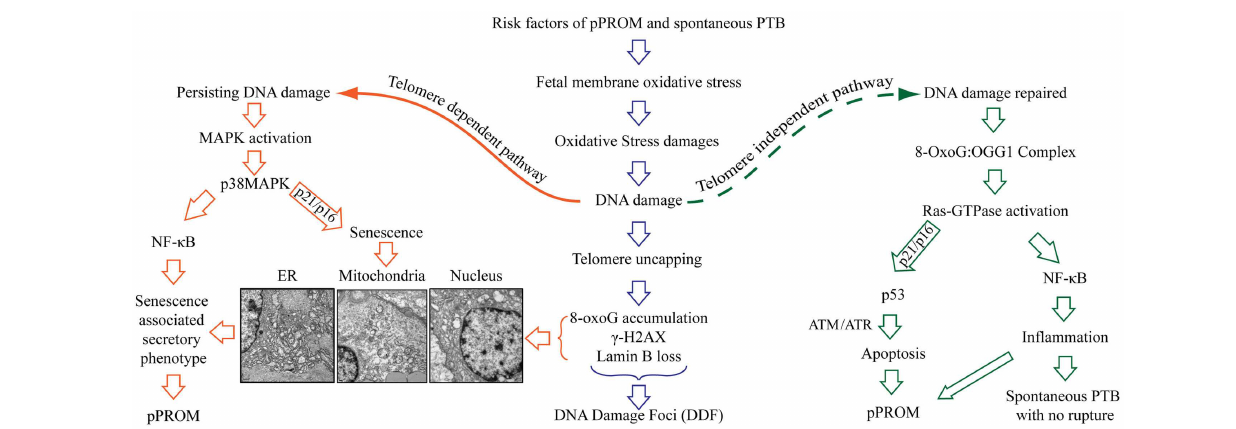
FIGURE 5 | Oxidative stress-induced pathways of pPROM and spontaneous PTB with intact membranes . Risk factors of pPROM and PTB – like infection, obesity, poor nutrition, stress, behavioral risk factors (cigarette smoking, drinking, and drug abuse) – can cause oxidative stress (OS) in human fetal membranes that leads to OS-induced damages to all major cellular elements (lipids, proteins, and nucleic acid). Damages to DNA are especially lethal to fetal membranes and placental cells because they lead to oxidation of guanine base, resulting in mutagenic 8-OxoG formation. Telomeres are rich in G bases, and oxidation G bases lead to telomere attrition as a part of damage repair [base excision repair (BER)].The pathway of pPROM and PTB may be delineated at this stage based on the type of risk and the type of OS response: overwhelming OS (chronic OS with smoking, alcohol use, obesity, poor nutrition, etc.) vs. infection/inflammation-related acute OS by fetal cells or immunocytes. Overwhelming OS can lead to persistent DNA damage and telomere reduction, 8-OxoG formation, resulting in DNA damage foci (DDF) formation.Telomere-dependent pathway – when